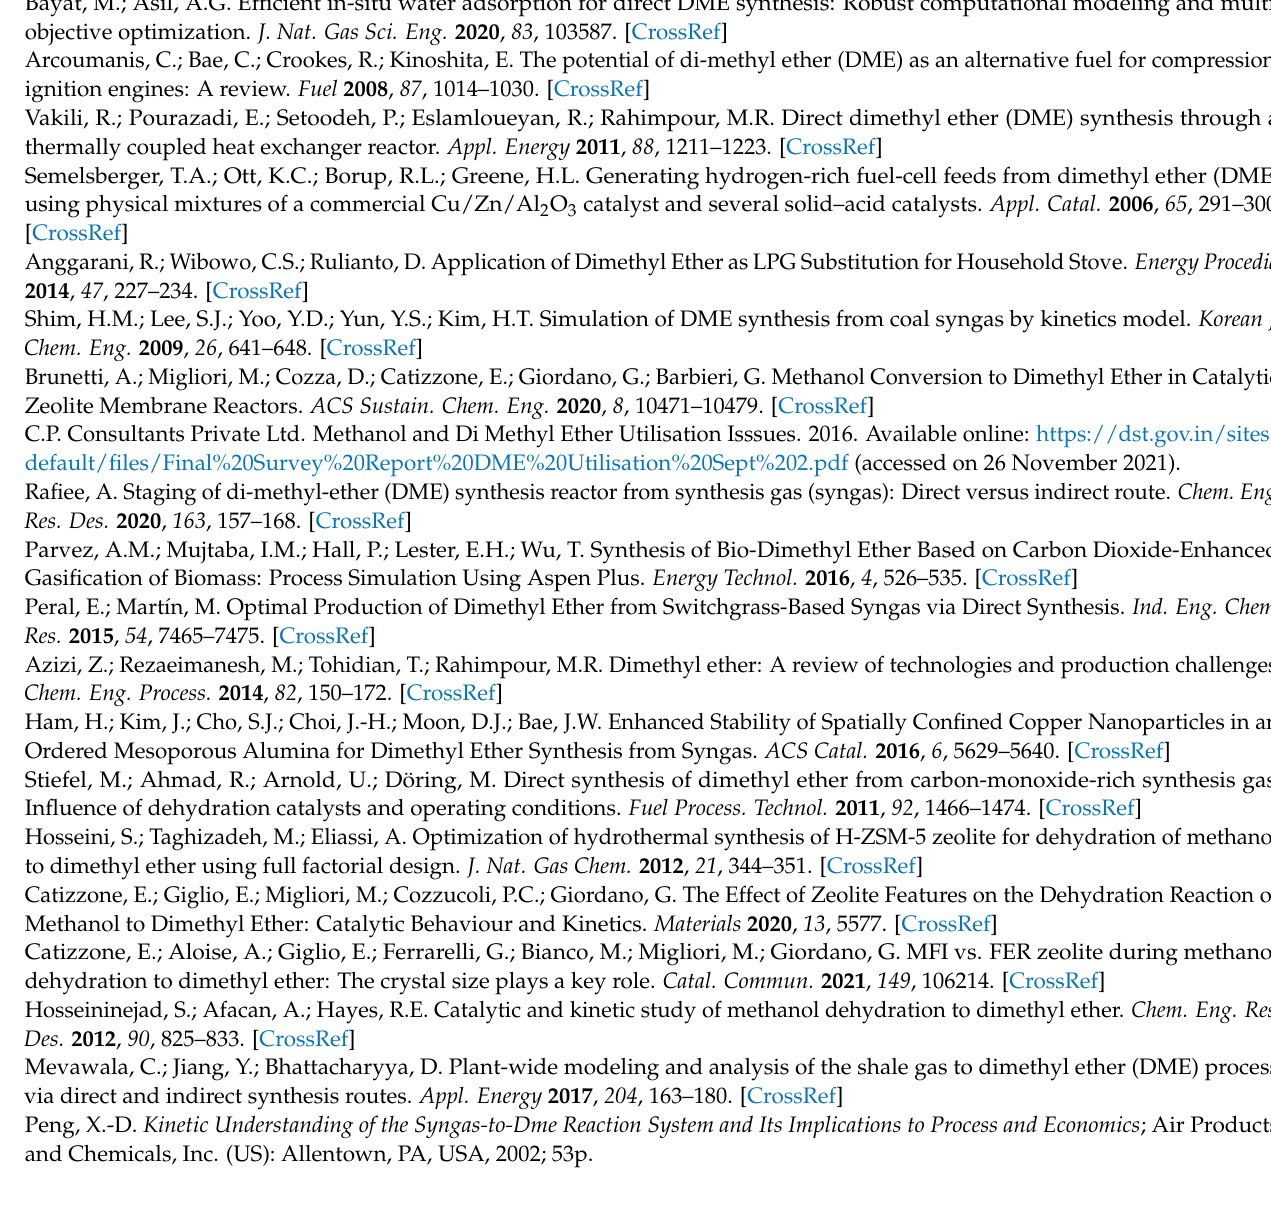
temperature in the reactor. Figure S6. Influence of the feed pressure on the maximum temperature in the reactor. Figure S7. Influence of the H 2 to CO ratio on the maximum temperature in the reactor. Figure S8. Influence of CO 2 mole fraction on the maximum temperature in the